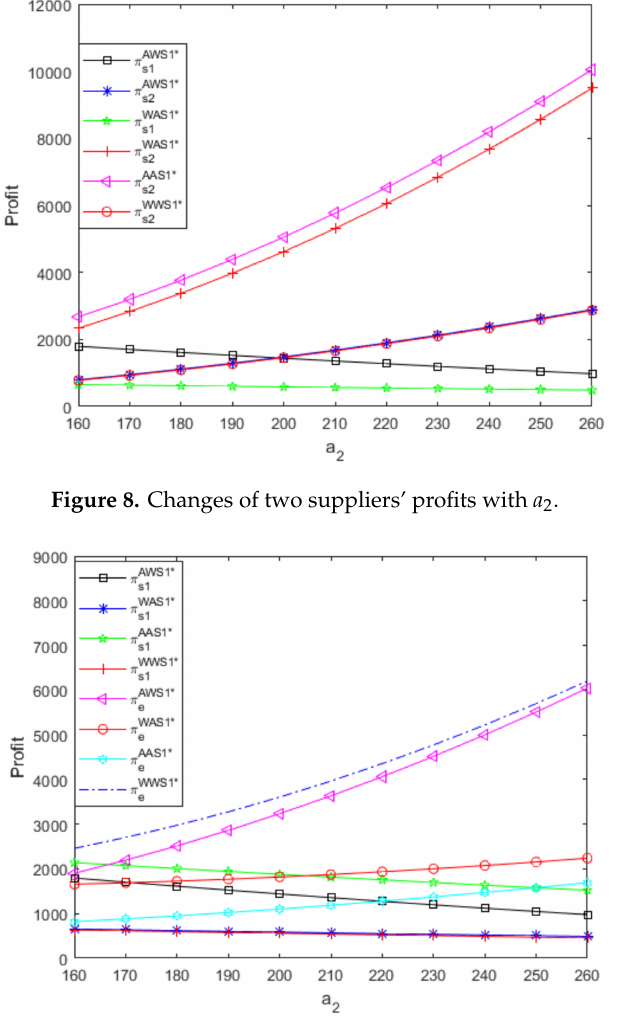
Figure 9. Changes of supplier 1’s and e-retailer’s profits with a 2